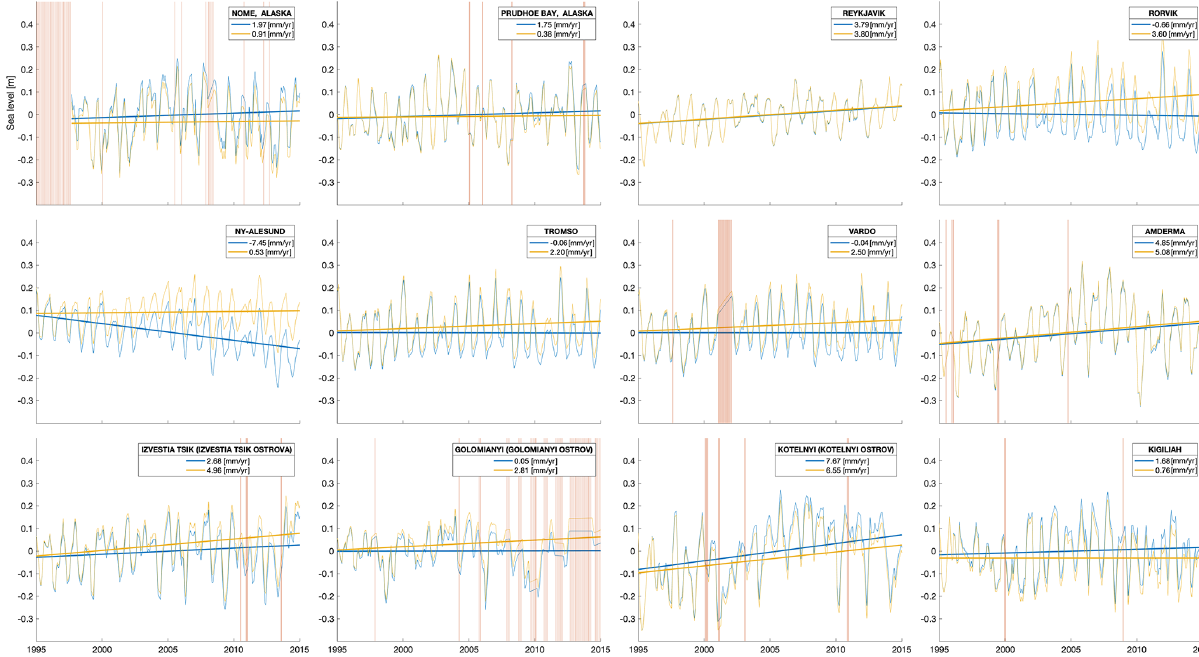
Figure 2. Relative sea level [m] from 1995–2015 registered at the 12 tide gauges from the PSMSL database (Holgate et al., 2012; PSMSL, 2020). The blue line represents the 3-month running average, while the thick line is the linear trend (trend estimate in mmyr − 1 shown in the legend). The yellow line represents the absolute sea level and trend, equal to the blue line corrected for VLM with a VLM model (Ludwigsen et al., 2020b) (except Ny-Ålesund and Reykjavik that are corrected with an extrapolated GNSS trend). The vertical lines indicate where observations are missing and the sea level is linearly interpolated from adjacent months.